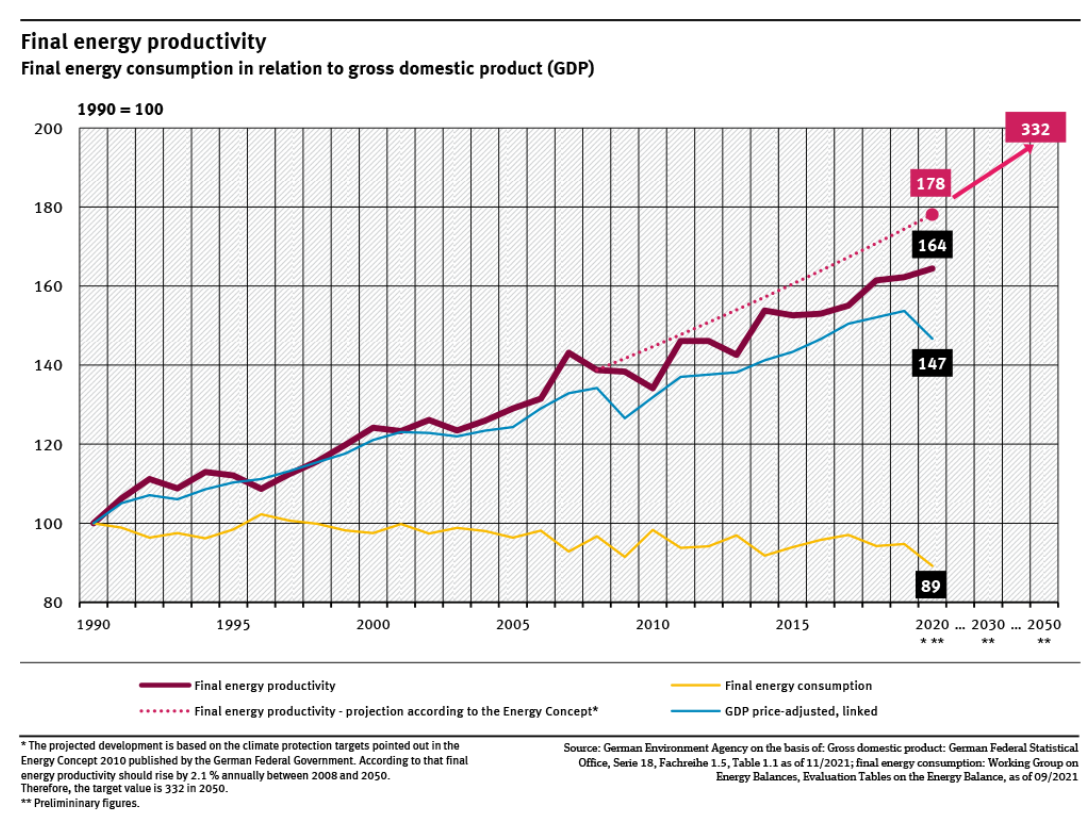
Figure 3. Final energy productivity 1990 – 2020 [20]. (Source Umweltbundesamt